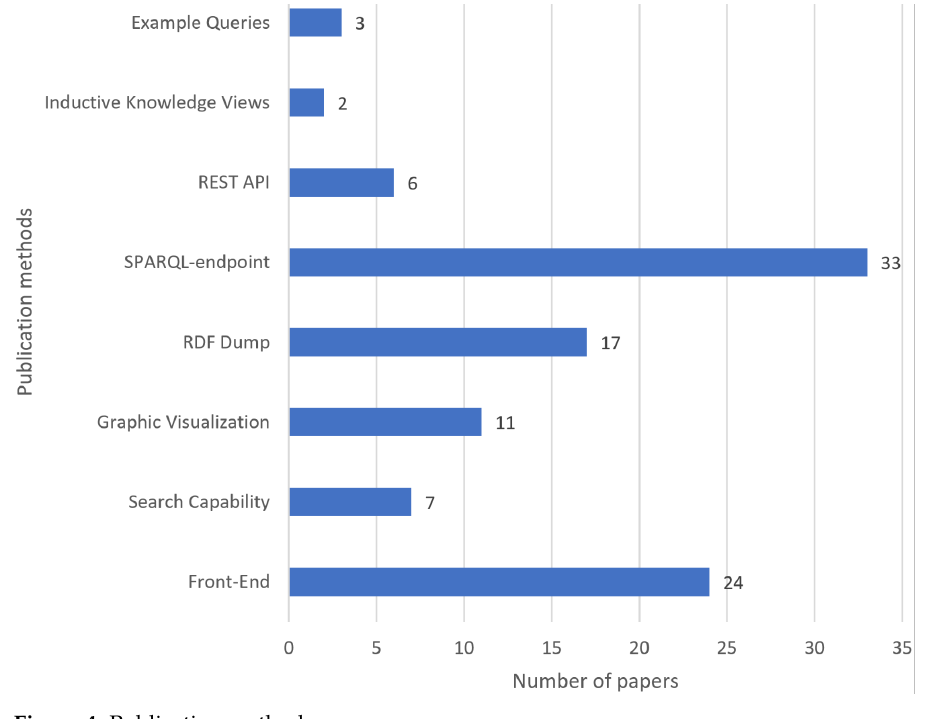
Figure 4. Publication methods.